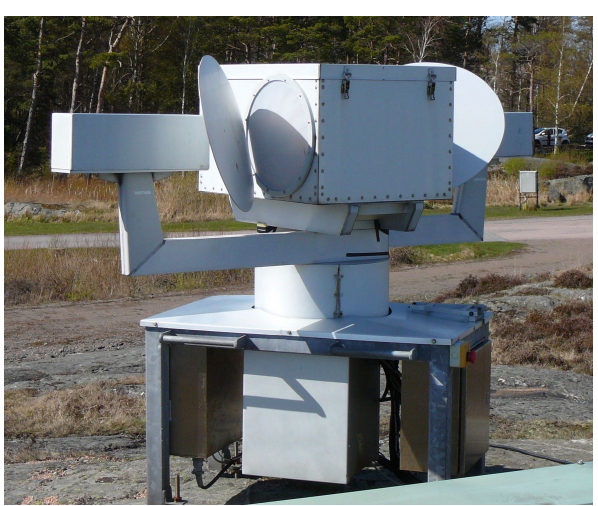
Figure 4. The water vapour radiometer (WVR) Konrad at the On- sala Space Observatory.